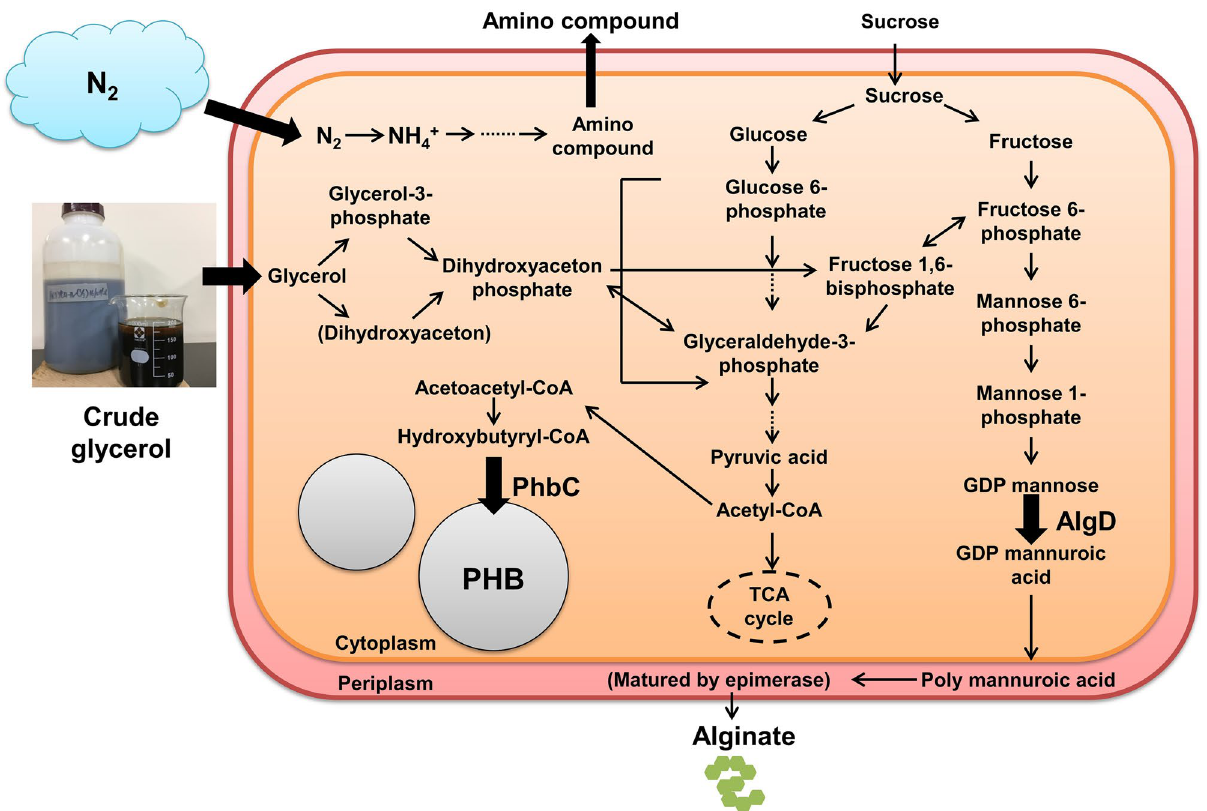
Figure 6. Model and metabolic map of crude glycerol recycling in A. vinelandii